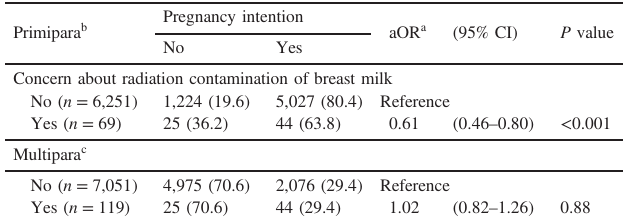
Table 3. Mothers ’ pregnancy intention and concern